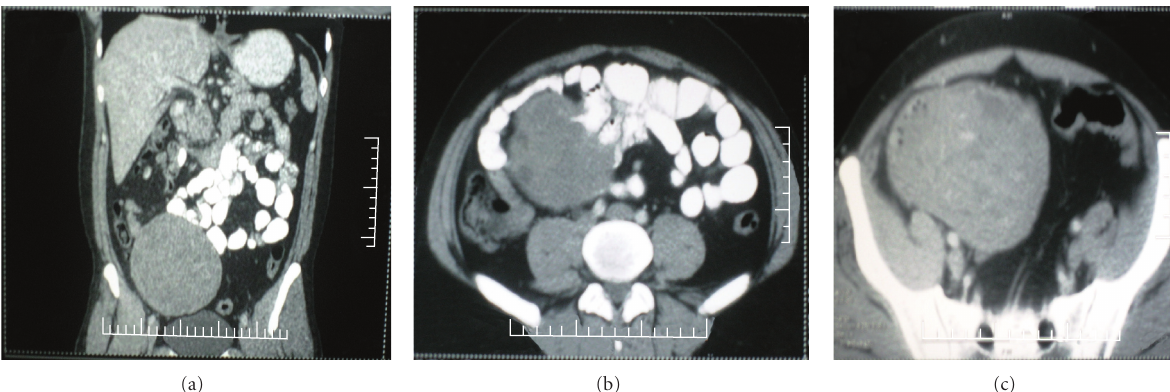
Figure 1: Computed tomography enteroclysis showing a large well-defined heterodense ovoid space occupying lesion measuring 15 × 10cm with clumped bowel loops seen in right iliac fossa.